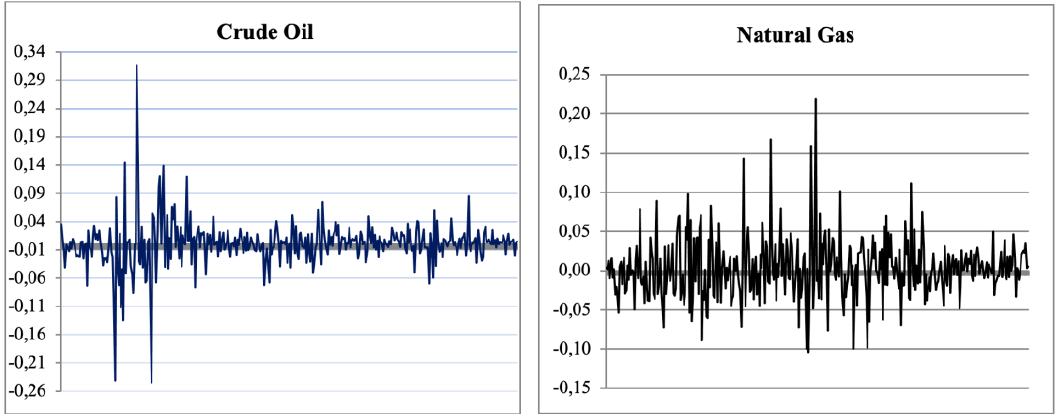
Figure 2: Trends of crude oil and natural gas prices; Source: Author’s compilation